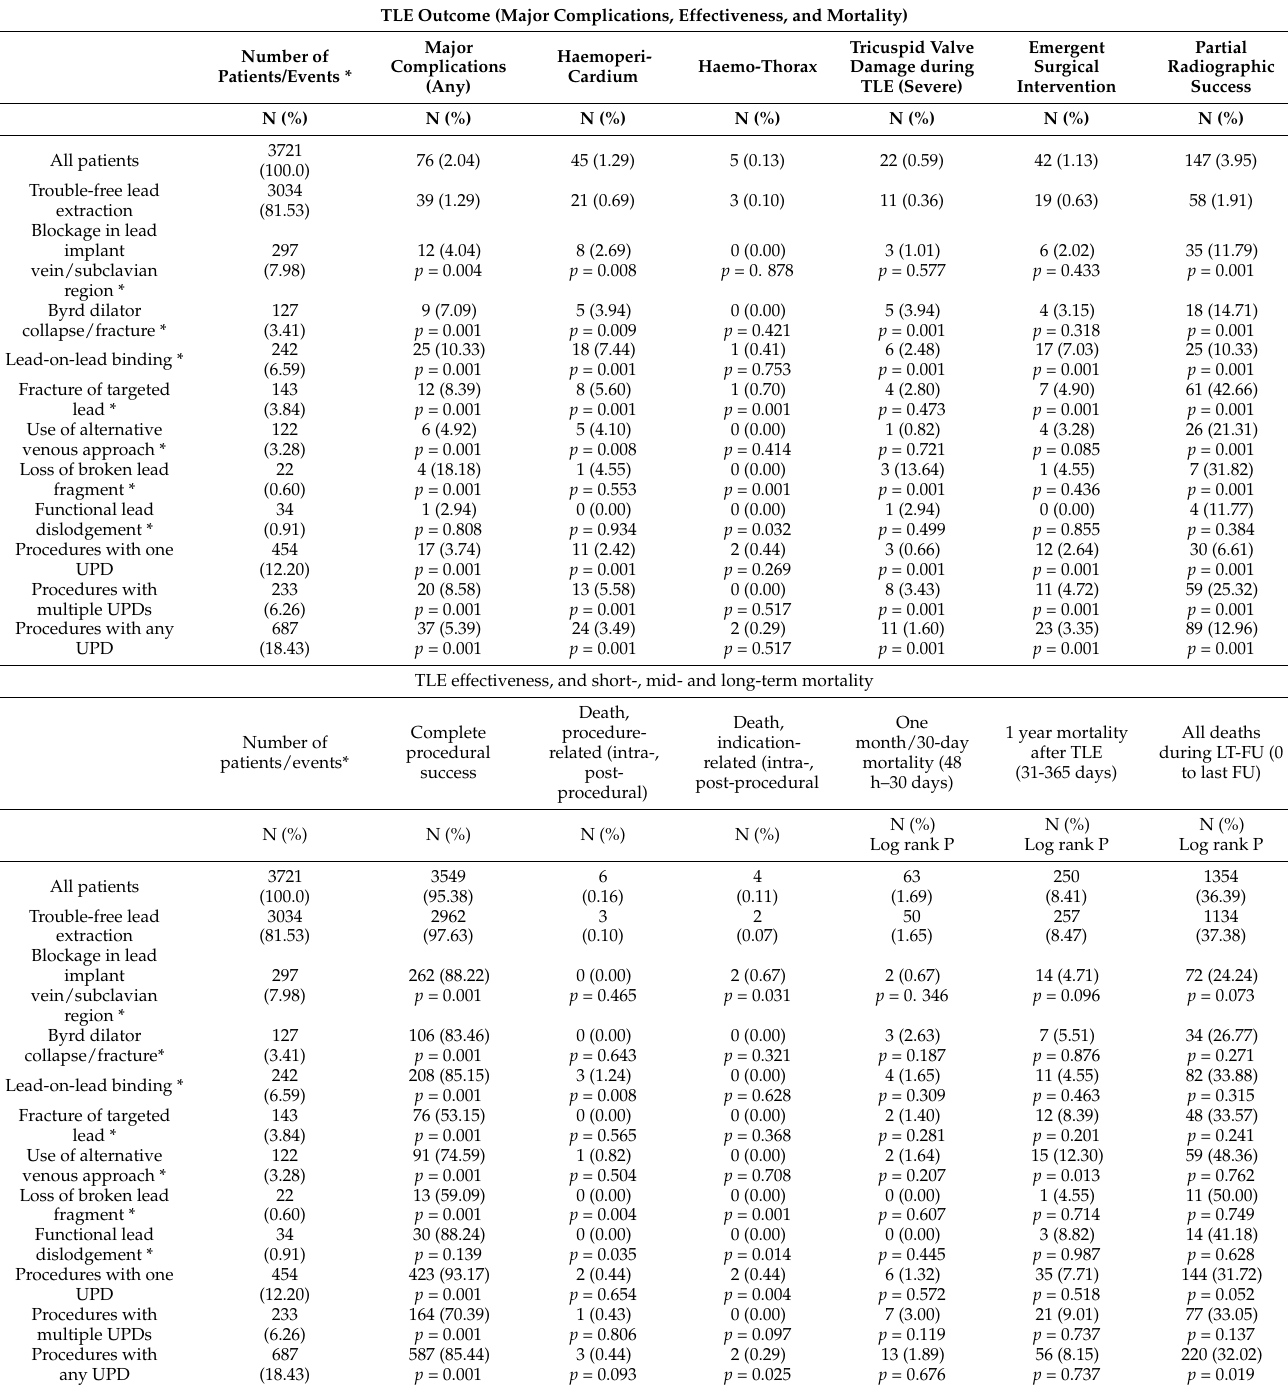
Table 5. Major complications of lead extraction, effectiveness, and short-, mid- and long-term